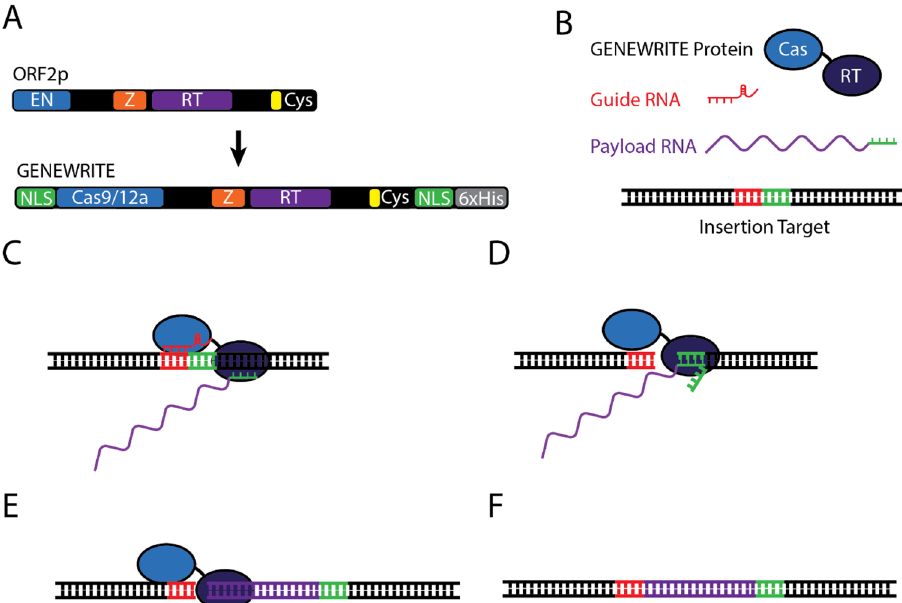
Figure 1. GENEWRITE components and strategy. ( A ) ORF2p and GENEWRITE domain structure. Wildtype ORF2p consists of endonuclease (EN, blue), Z (Z, orange), reverse transcriptase (RT), and cysteine-rich RNA binding domains (Cys, yellow). The GENEWRITE protein replaces the EN domain with a Cas protein (Cas9 or Cas12a/Cpf1, blue) and includes an N-terminal EGL13 nuclear localization signal (NLS, green), C-terminal c-Myc NLS (NLS, green), and 6xHis tag for in vitro purification (His, gray). ( B ) GENEWRITE components. The system consists of the GENEWRITE protein and a DNA target for insertion. A guide sgRNA complementary to the desired cut site (red) and a payload RNA encoding the desired insertion with a 3’ end designed to hybridize to the insertion target (green). Optionally, as described in the text, NHEJ proteins, ORF1p protein, and 5’ homology on the payload RNA to the target site can be included to increase insertion efficiency. ( C ) The sgRNA directs Cas cleavage to the integration site. ( D ) After Cas-induced cleavage, the 3’ end of the payload RNA hybridizes with the cut site priming TPRT ( E ). After mRNA removal and second strand synthesis by host enzymes, the cut site is resolved ( F